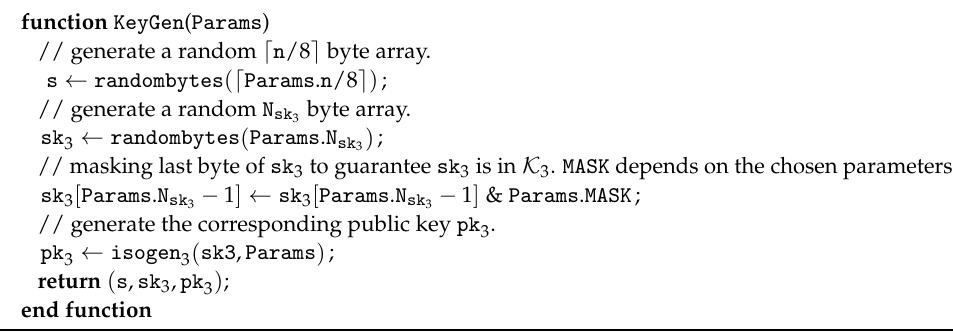
Algorithm 1 Key generation algorithm for SIKE.